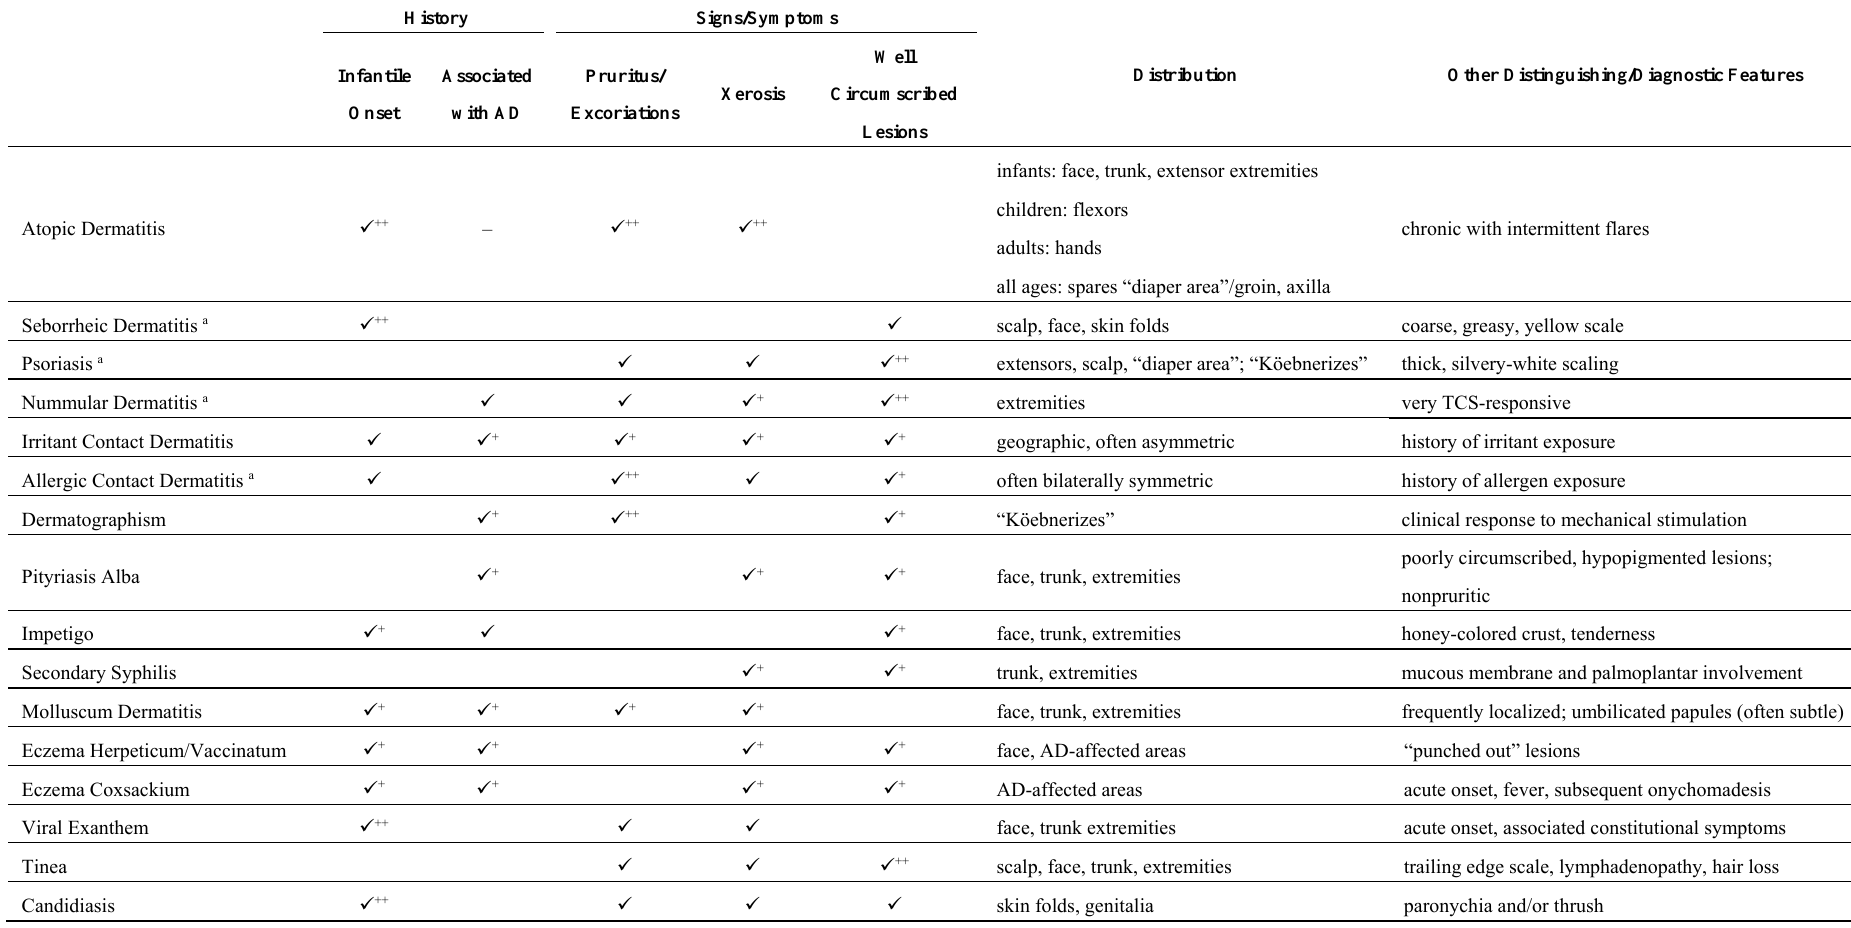
Table 4. Distinguishing clinical features of most prominent differential diagnoses. [blank] indicates rare/unusual;  , sometimes;  + , often/usually;  ++ , always/nearly always/most often; Δ , variable; –, not applicable; AD, atopic dermatitis; ARCI, autosomal recessive congenital ichthyosis; CS, corticosteroids; CTCL, cutaneous T-cell lymphoma; TCS, topical corticosteroids; XLRI, X-linked recessive ichthyosis; a Concurrent disease may be observed ( i.e. ,